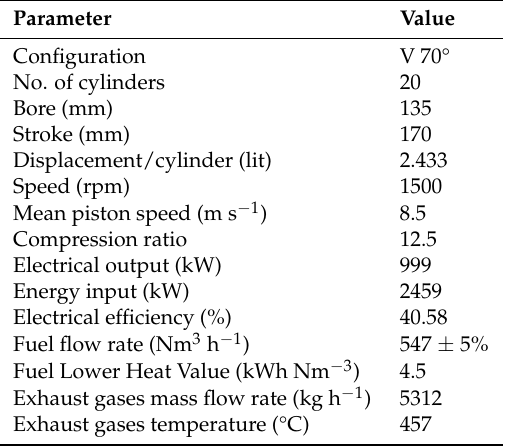
Table 4. Biogas engine design